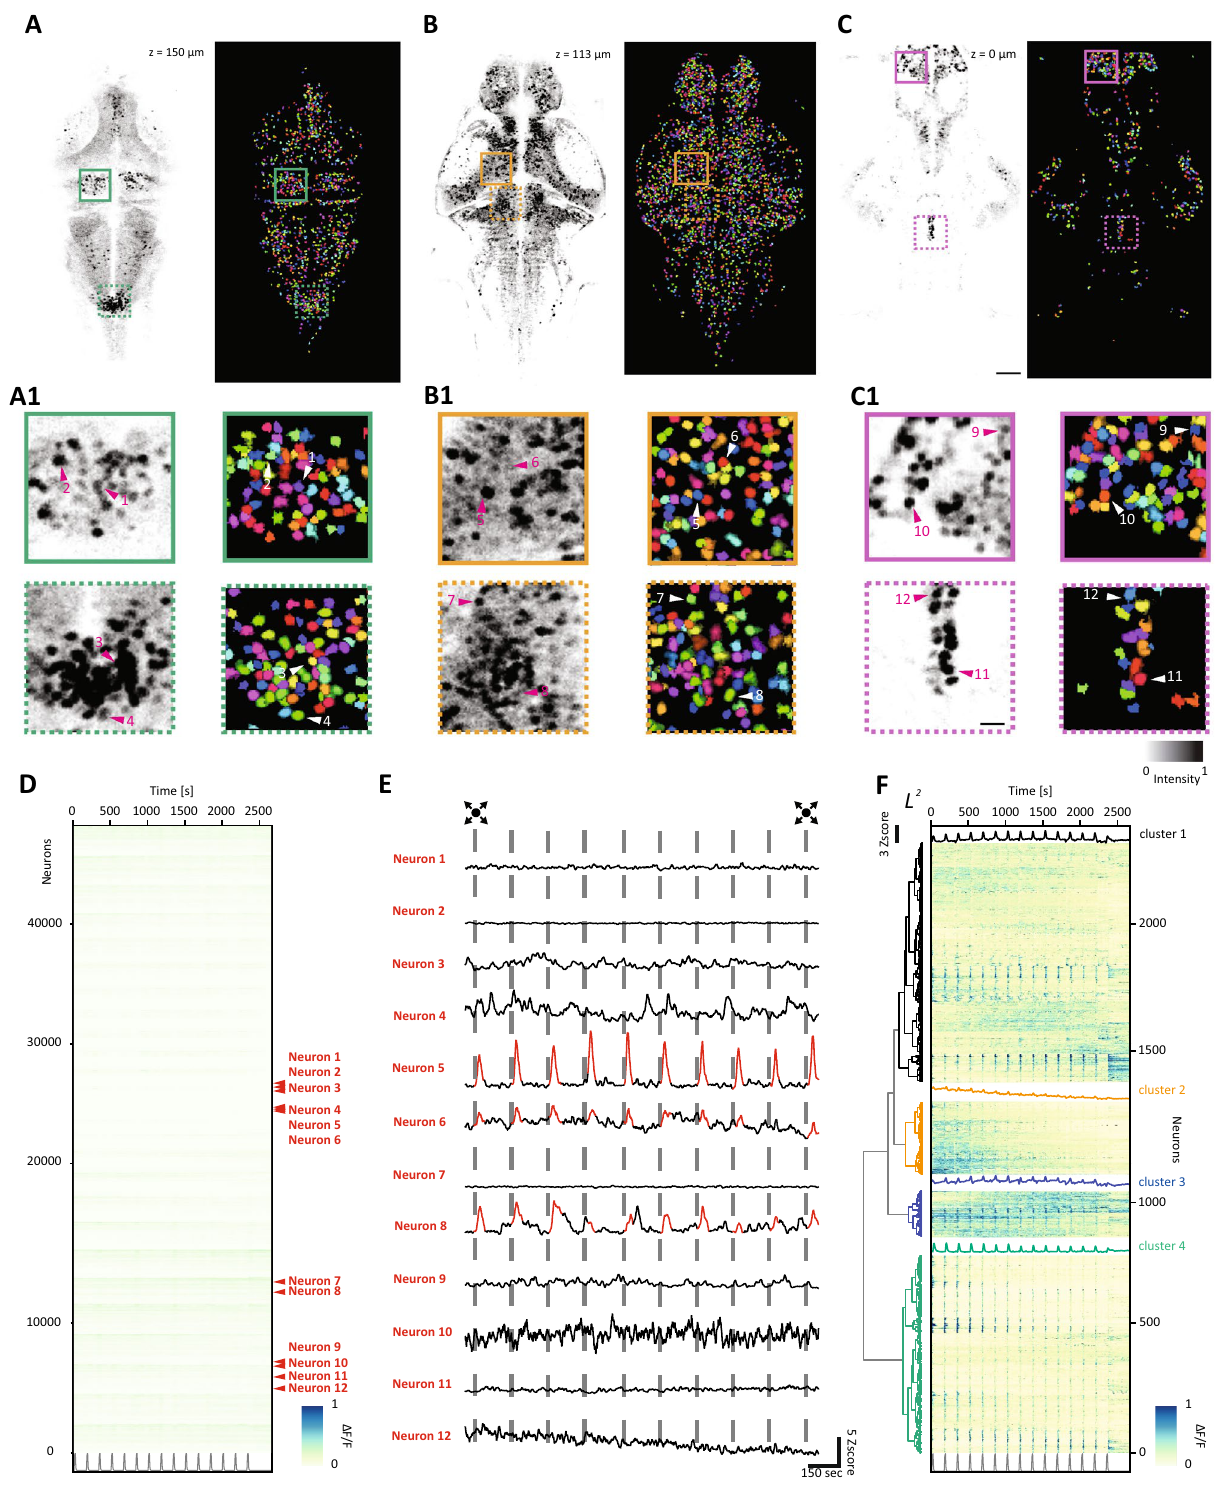
Figure 4. Whole brain calcium imaging. ( A–C ) Average intensity projections (left) and the results of the cell segmentation process (right) for a dorsal ( A ), central ( B ) and ventral ( C ) planes of the fish corresponding to the z-levels at + 150 μm, + 113 μm and + 0 μm, respectively. The colored boxes indicate the areas of the inset ( A1 – C1 ). Scale bar = 50 μm. ( A1–C1 ) Representative fields of view of the average intensity projections (left) and of the segmentation (right) extracted from ( A – C ). Arrows indicate corresponding cell bodies. Scale bar = 10 μm. ( D ) Raster plot showing the activity profiles of the complete dataset of 47,992 neurons segmented as function of the time. The neurons corresponding to the ( A1 – C1 ) insets are indicated in red. The grey trace at the bottom indicates the stimulation. ( E ) The activity profiles expressed as z-score for the neurons highlighted in ( D ). The vertical bars indicate the presentation of the looming stimulation. ( F ) Hierarchical clustering and raster heatmap of the 2400 stimulus-responding neurons identified with the regression analysis. For each cluster the average response is overlaid in the corresponding color. The grey trace at the bottom indicates the